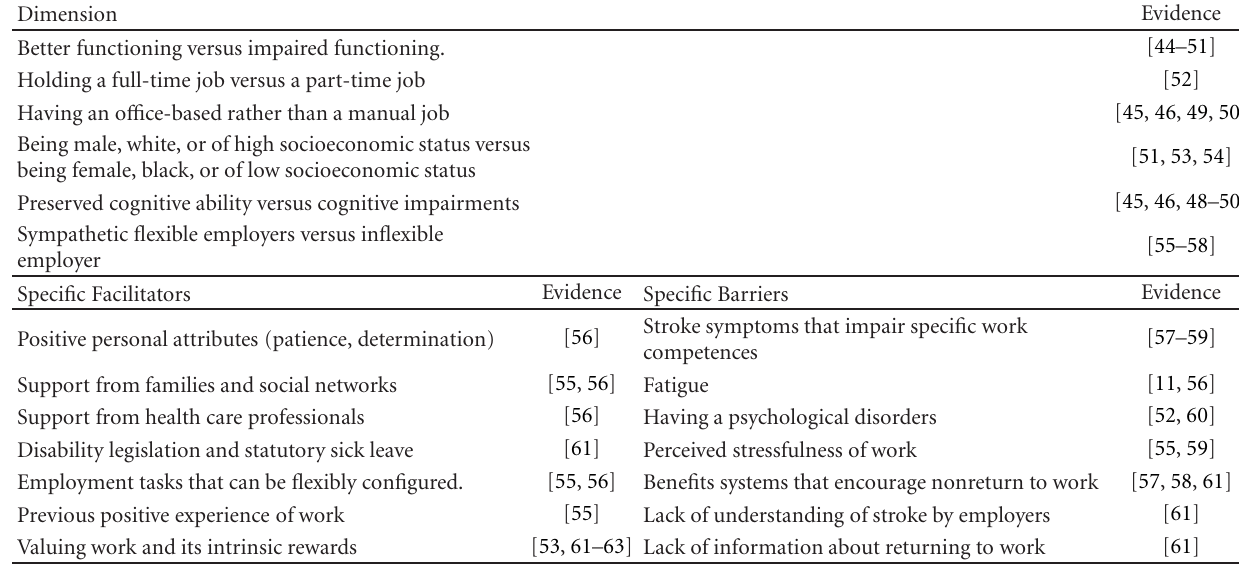
Table 2: Facilitators and barriers for return to